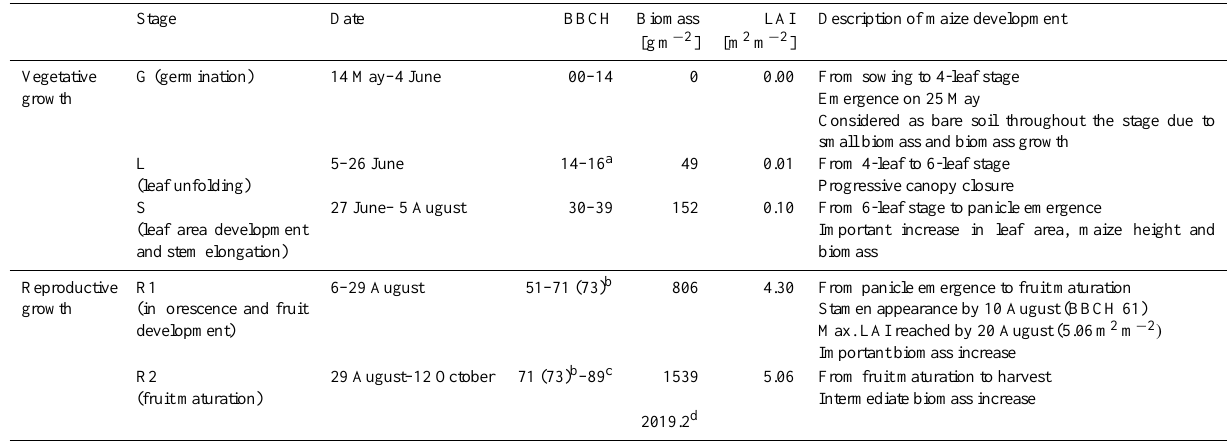
Table 2. Maize phenological development. BBCH codification refers to Meier (2001). Both biomass and LAI refer to the beginning of a